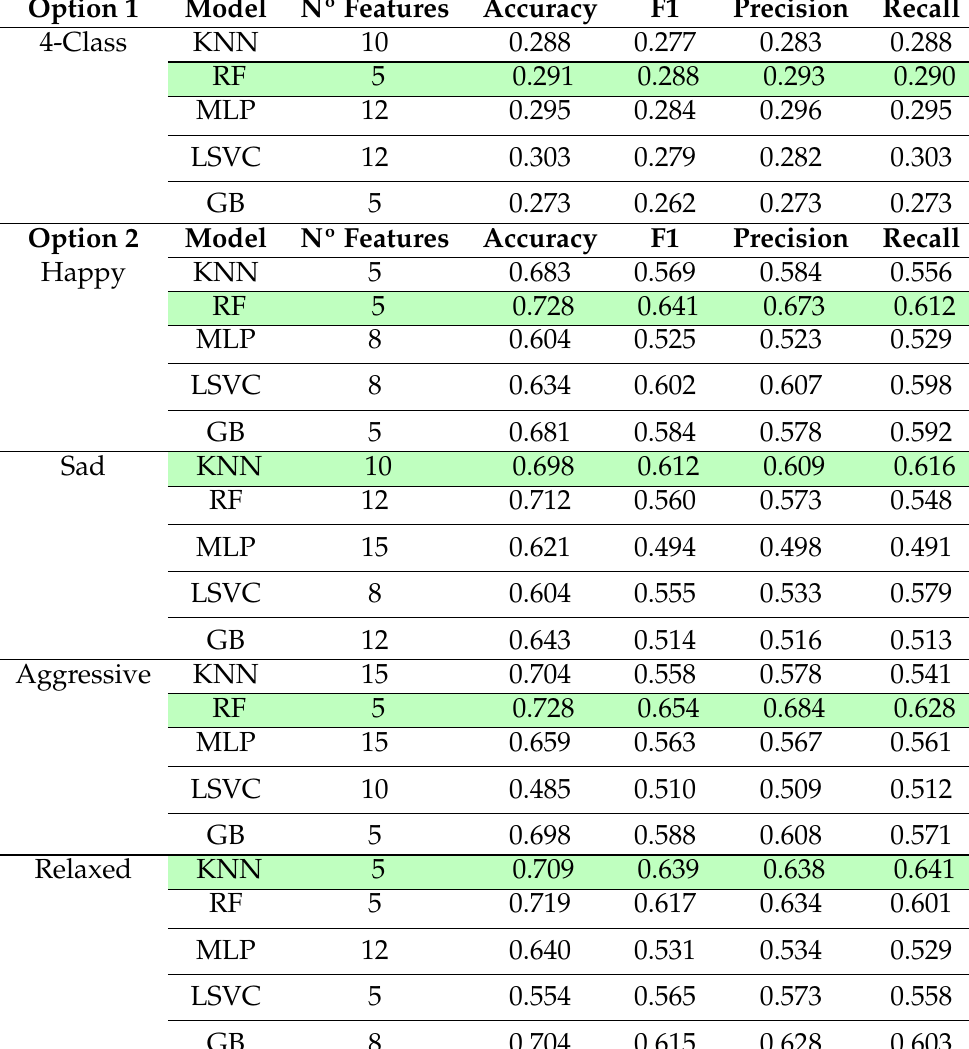
Table 3. Machine learning models for each classification approach (the best model is highlighted in green